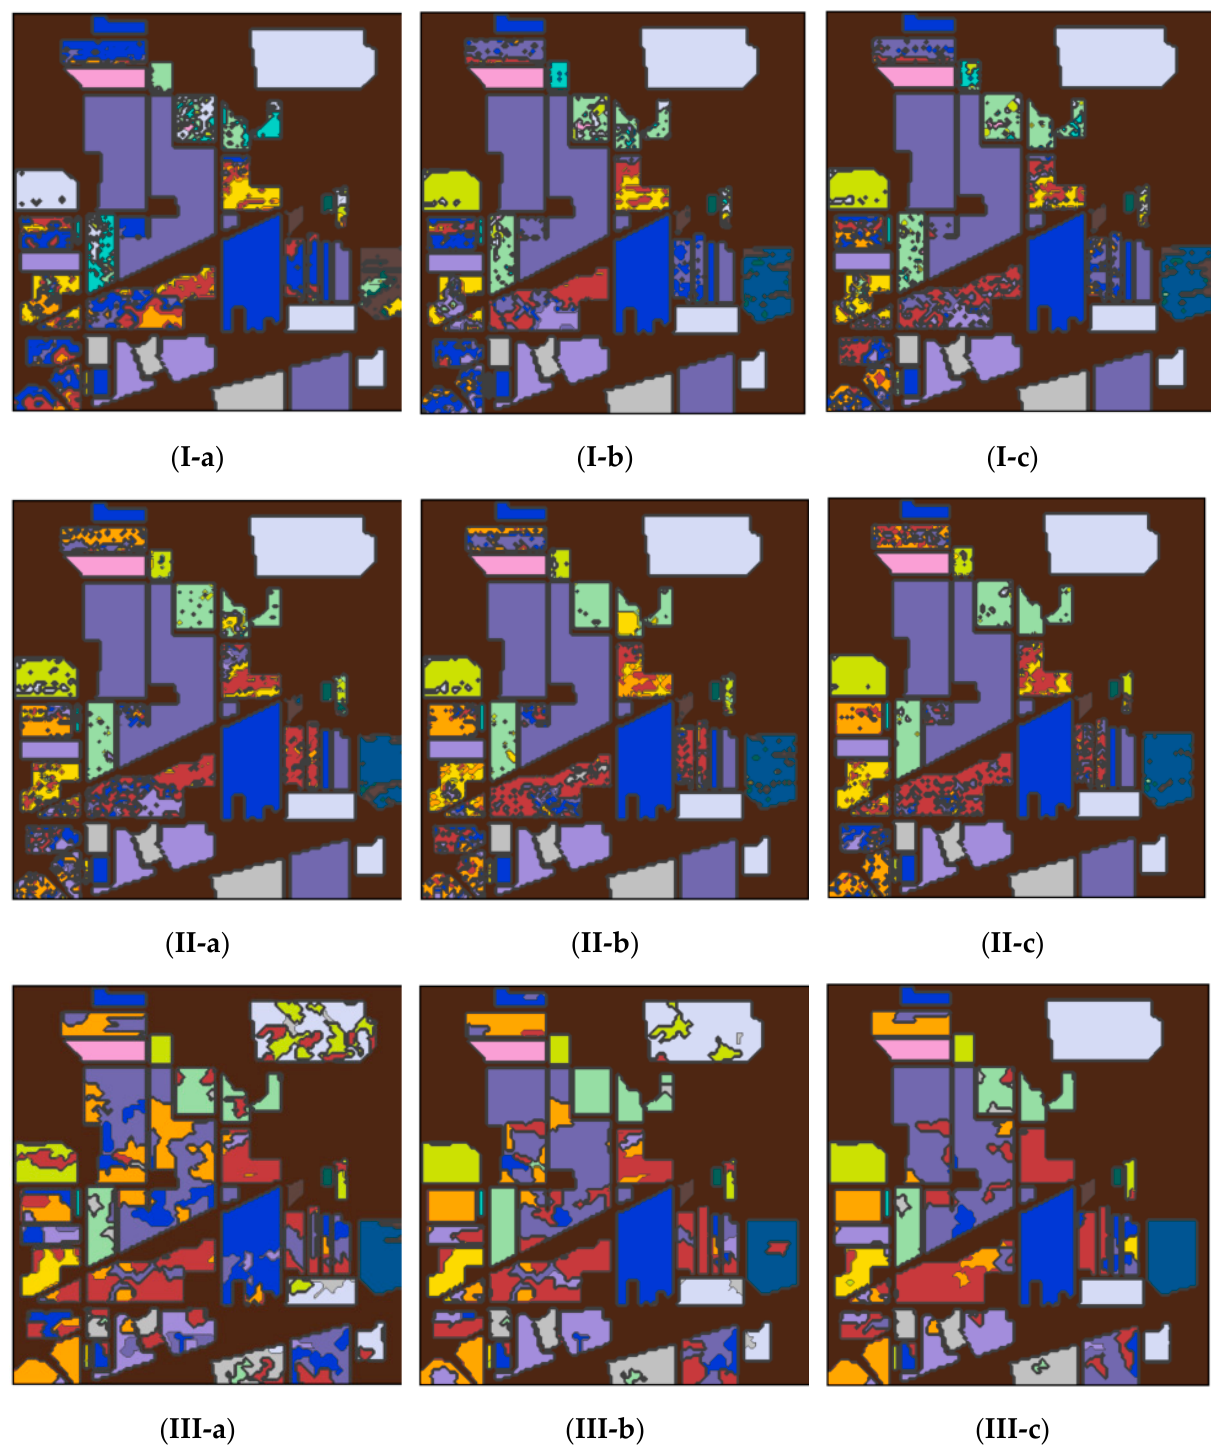
Figure 7. Indian Pines classification results. ( a ) KNN. ( b ) SVM. ( c ) Proposal. ( I ) Training sample 10. ( II ) Training sample 30. ( III ) Training sample 50.